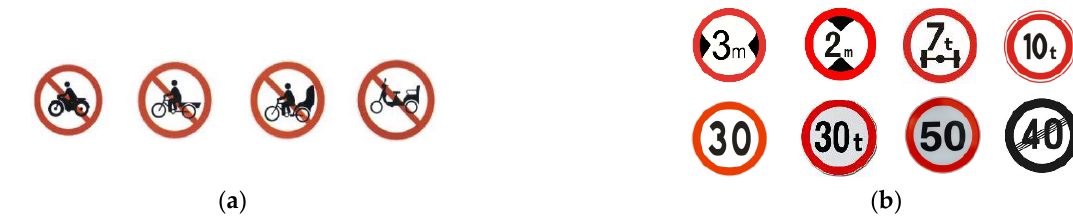
Figure 1. ( a ) Some examples of prohibitory signs. ( b ) Specific traffic signs, including height, width, and the speed limit.